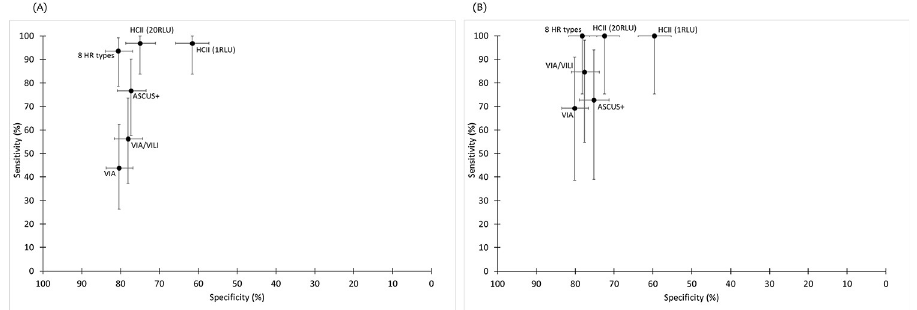
Fig 2. Sensitivity and specificity of screening strategies for prevalent CIN2+ and CIN3+ in Burkina Faso. (A) CIN2 +; (B) CIN3+. ASCUS+, atypical squamous cells of undetermined significance, or greater; CIN, cervical intraepithelial neoplasia; HCII, Hybrid Capture 2; HR, high risk; RLU, relative light unit; VIA, visual inspection using acetic acid; VILI, visual inspection using Lugol’s iodine.